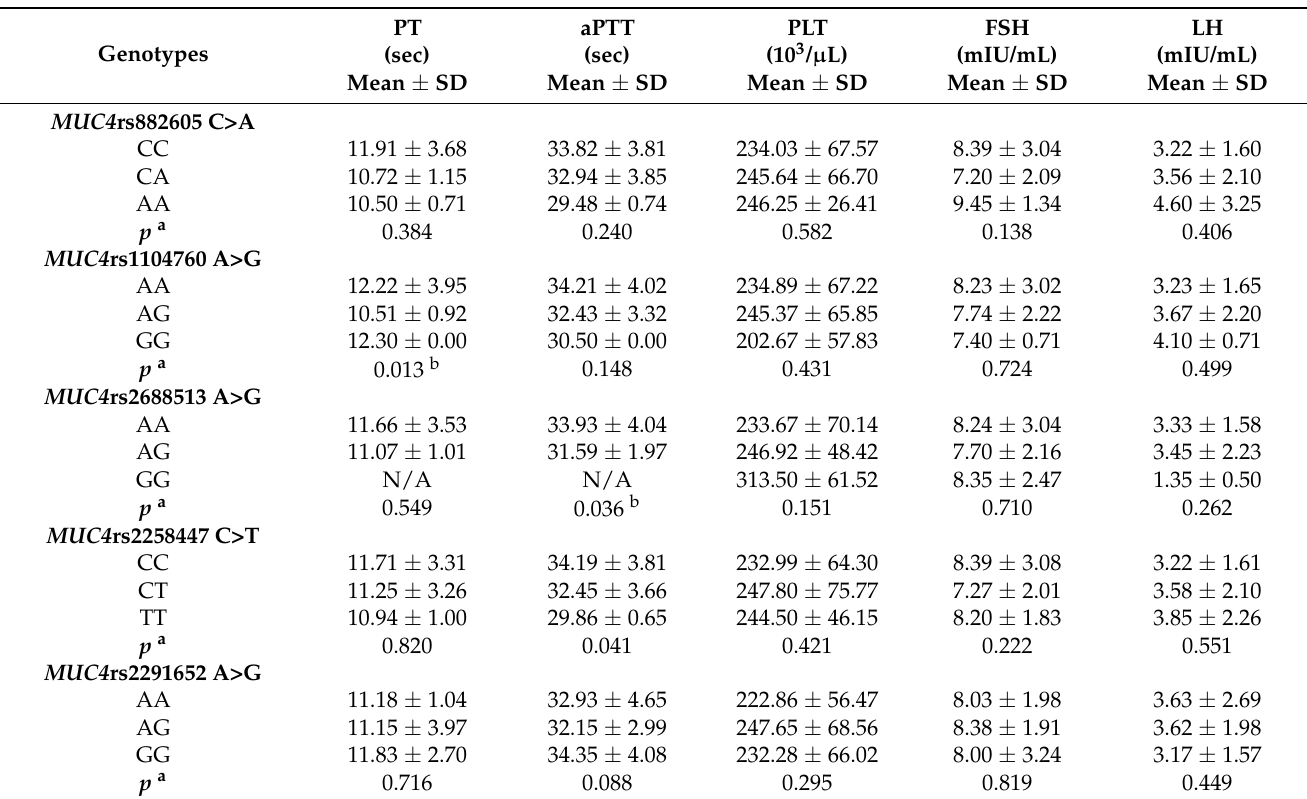
Table 5. Differences in the various clinical parameters according to the MUC4 polymorphisms in the RPL